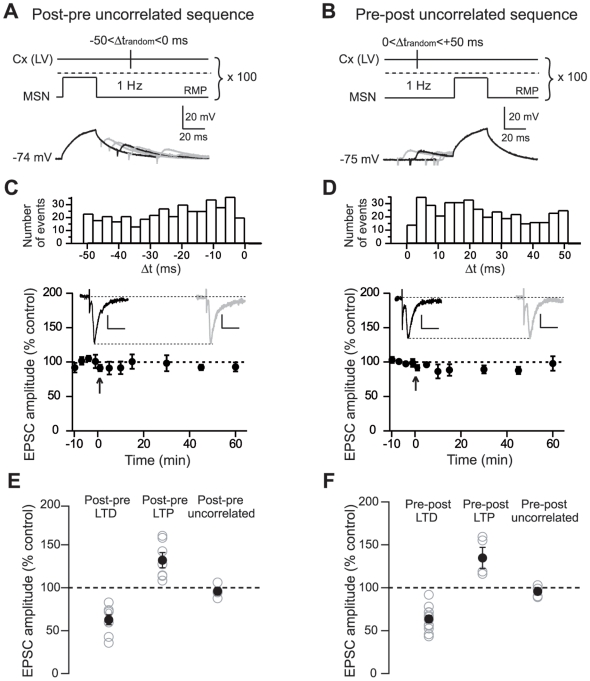
Uncorrelated random paired stimulations failed to induce significant long-term synaptic plasticity.(A–B) Uncorrelated post-pre (A) and pre-post (B) SDDP protocols consisted in varying randomly postsynaptic subthreshold depolarizations and presynaptic stimulations delays for each sweep of the pairing period Δtrandom (range of random delays: −50 to 0 ms for post-pre sequences and 0 to +50 ms for pre-post sequences). Below: examples of five consecutive postsynaptic MSN recordings (superimposed raw traces) during post-pre (A) and pre-post (B) random pairings. (C–D) Mean effect of pairing with random delays for post-pre (n = 4 MSNs) (C) and for pre-post (n = 4 MSNs) (D) sequences. An absence of long-term synaptic efficacy changes was observed in both groups (post-pre and pre-post random pairings). Insets: EPSCs evoked before (black traces) or 60 minutes after the uncorrelated sequences (grey traces). Scale bars are 50 pA and 20 ms. Arrows indicate the cellular conditioning protocol. Upper panels show the distribution of random pairing delays across all cells for uncorrelated post-pre (−50<Δtrandom<0 ms) (E) and pre-post (0<Δtrandom<+50 ms) (F) SDDP sequences. (E–F) Long-term synaptic efficacy changes are illustrated for post-pre (E) and pre-post (F) correlated and uncorrelated paired SDDP. Open grey circles represent individual experiments and black circles represent average values. Post-pre (−50<Δtrandom<0 ms) or pre-post (0<Δtrandom<+50 ms) uncorrelated paired stimulations did not induce significant long-term plasticity in contrast to correlated pairings.